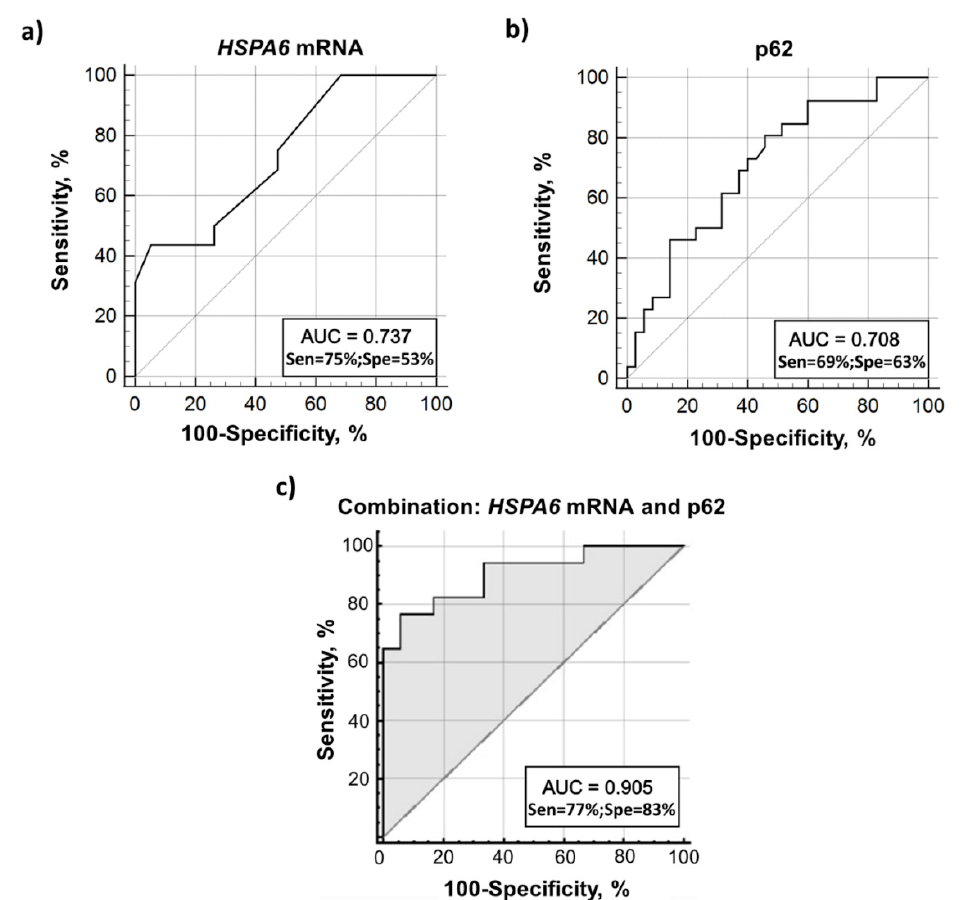
Figure 4. ROC curve analysis showing HSPA6 gene expression levels and p62 protein levels as potential biomarkers of PD. ( a ) The HSPA6 mRNA levels in PBMC showed 75.0% sensitivity and 52.63% specificity in distinguishing PD. ( b ) The p62 protein level in PBMC showed 69.23% sensitivity and 62.86% specificity in distinguishing PD. ( c ) Combination of HSPA6 mRNA and p62 protein showed 77% sensitivity and 83% specificity in distinguishing PD. ROC, receiver operating characteristic; AUC, the area under the ROC curve; Sen, sensitivity; Spe, specificity.